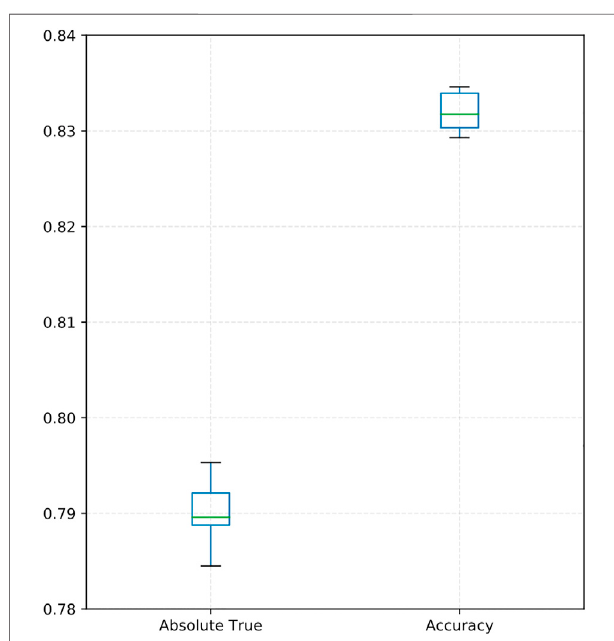
FIGURE 3 | Boxplot showing the absolute trues and accuracies of DACPGTN with 10-fold cross-validation for 10 times.